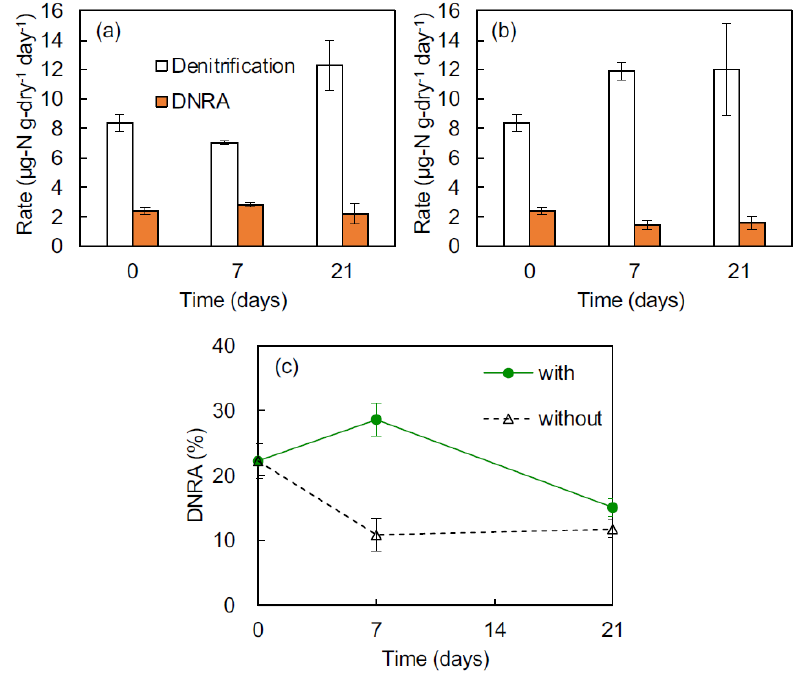
Figure 3. Changes in denitrification and DNRA rates in flasks with Ulva ( a ) and without Ulva ( b ) and contributions of DNRA to the total dissimilatory NO 3 − reduction in each treatment ( c